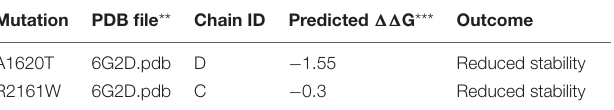
TABLE 2 | SDM* prediction of ACACA